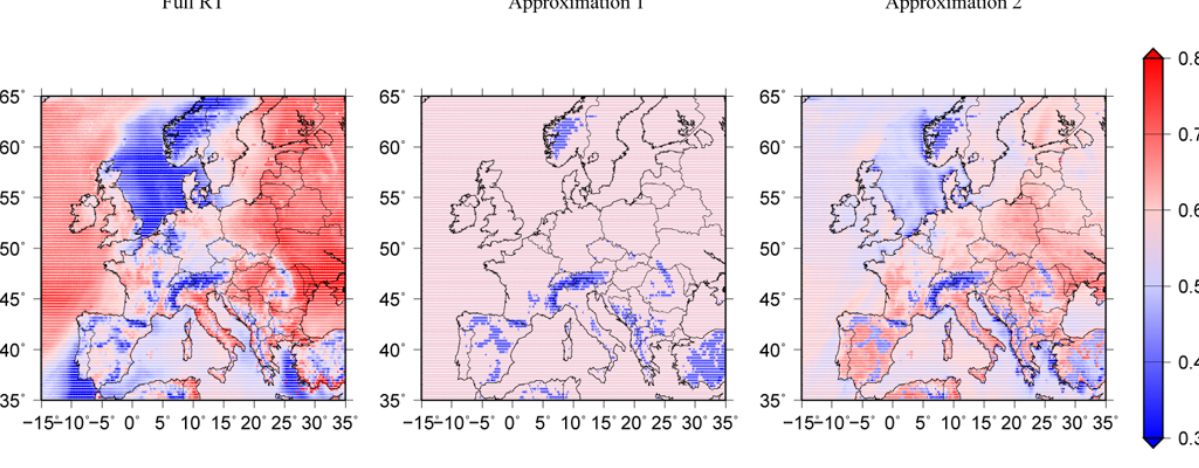
Fig. 4. Same as Fig. 3 but for the DOFs